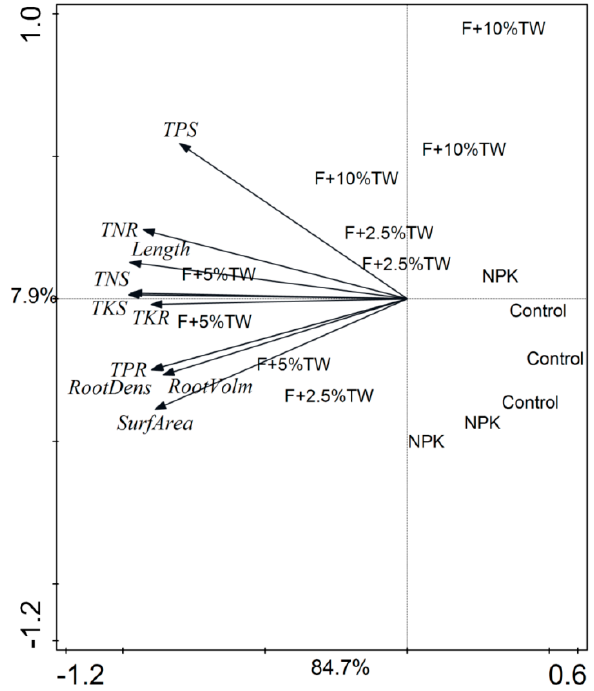
Figure 6. Principal component analysis (PCA) of root traits and plant NPK content of wheat crop. TNS (total nitrogen shoot), TNP (total nitrogen root), TPS (total phosphorus shoot), TPR (total phosphorus root), TKS (total potassium shoot), and TKR (total potassium root).